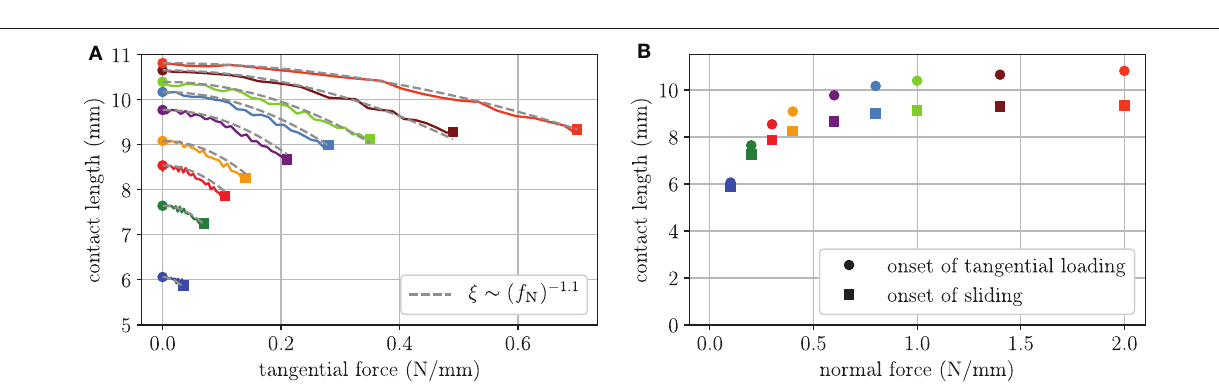
FIGURE 7 | Evolution of the contact length parallel to the tangential displacement of the two-dimensional finite element model with the coefficient of friction µ (A) contact length against tangential force per unit width. The dashed gray lines are fits in the form of Equation (34). (B) Contact length against normal force per unit width prior to tangential loading and at the onset of